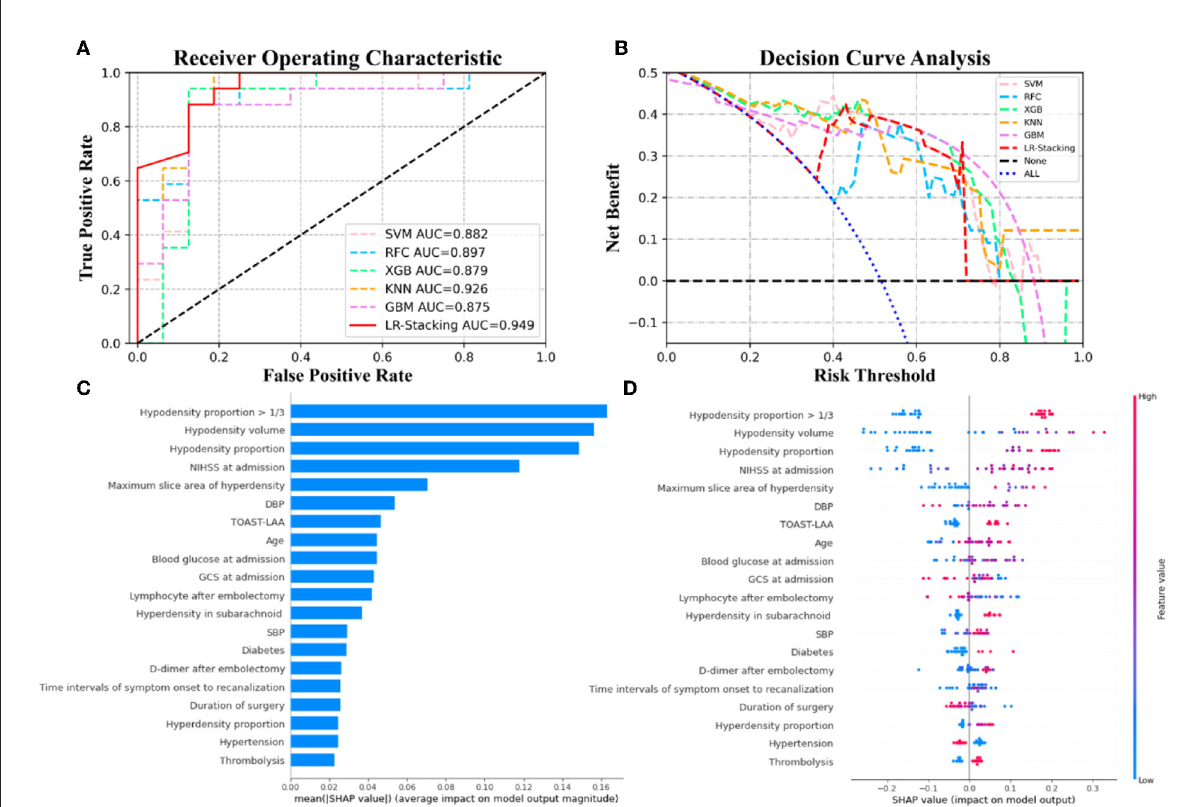
FIGURE3 The results from the ML models and contributions of various features to predicting futile recanalization. (A) The ROC curve of five ML models and LR-Stacking model. (B) The net benefit of the various models. (C) The features are listed in descending order according to the contributions from the LR-Stacking model. (D) The effects of the features on prediction. The colors indicate the value of each feature, from high (red) to low (blue). The horizontal location shows whether the effect of the value leads to a prediction of futile recanalization. Each point is a SHAP value of a feature for a